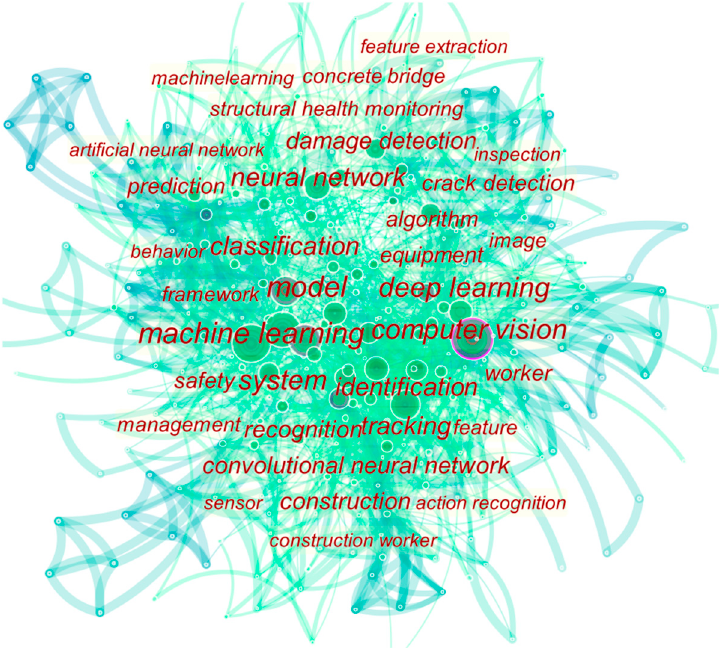
Figure 1. Co-occurrence network map.